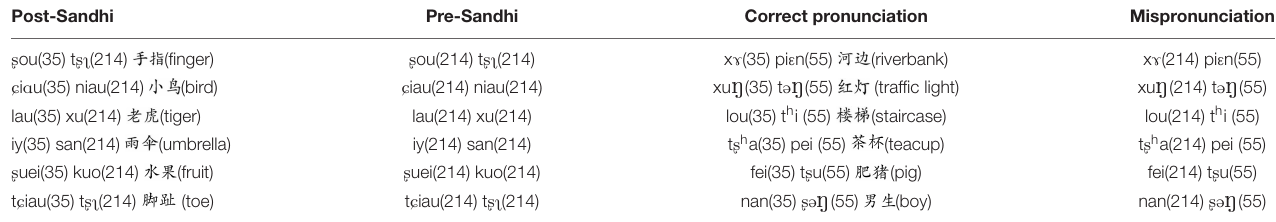
TABLE 2 | Target words and referents (in parentheses). Post-Sandhi Pre-Sandhi Correct pronunciation